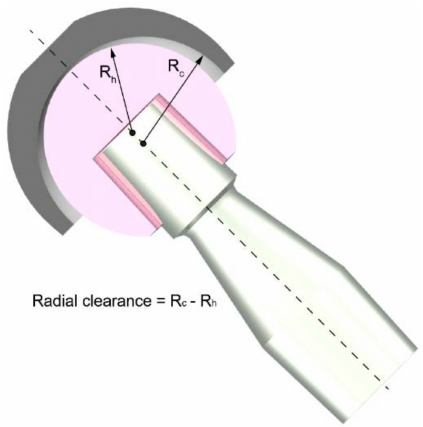
Figure 1. Schematization of the radial clearance between the inner surface of the acetabular cup (grey component in the picture) and the outer surface of the femoral head (pink component in the